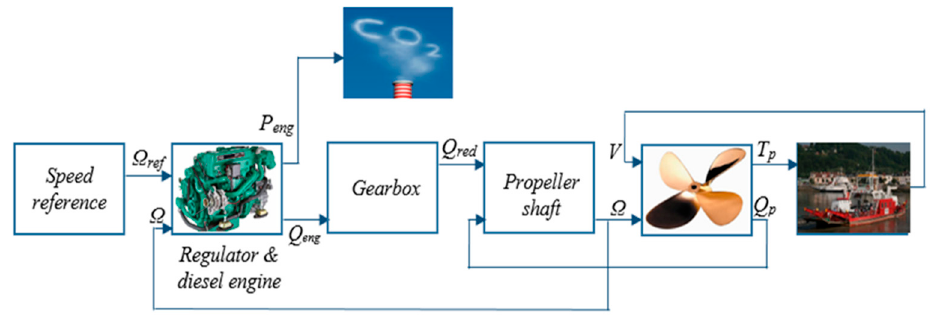
Figure 4. Schematic representation of the conventional chain model on Matlab/Simulink [12].